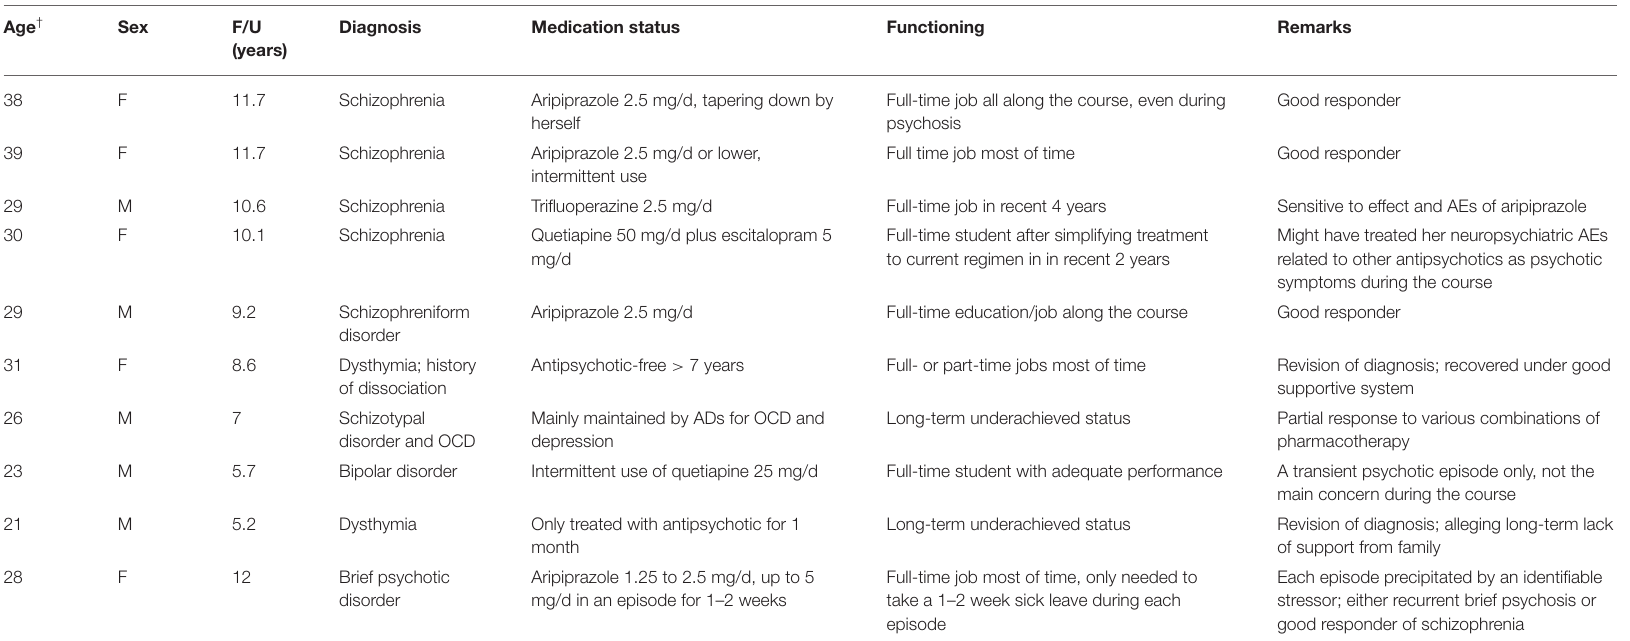
TABLE 4 | Summary of patients receiving only very-low-dose or no antipsychotic treatment during